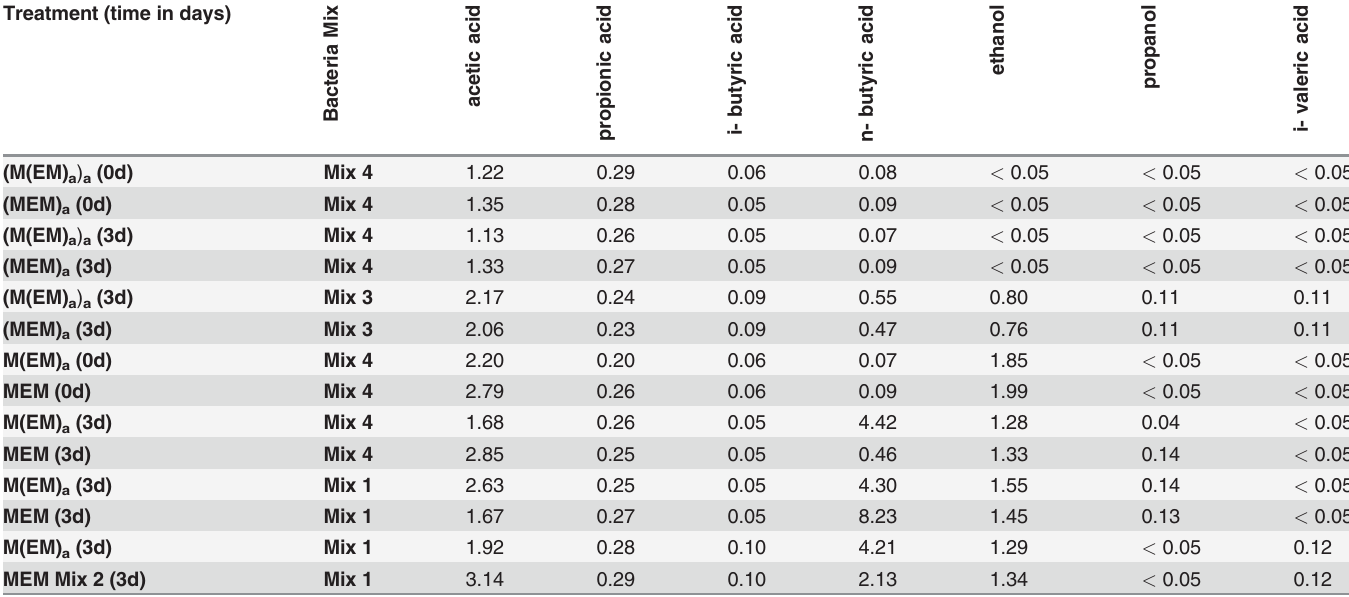
Table 5. Concentration (g / kg fresh weight) of VFA and alcohols in treatments MEM, M(EM) a , (MEM) a and (M(EM) a ) a at the start and after 3 days fermentation. Treatment (time in